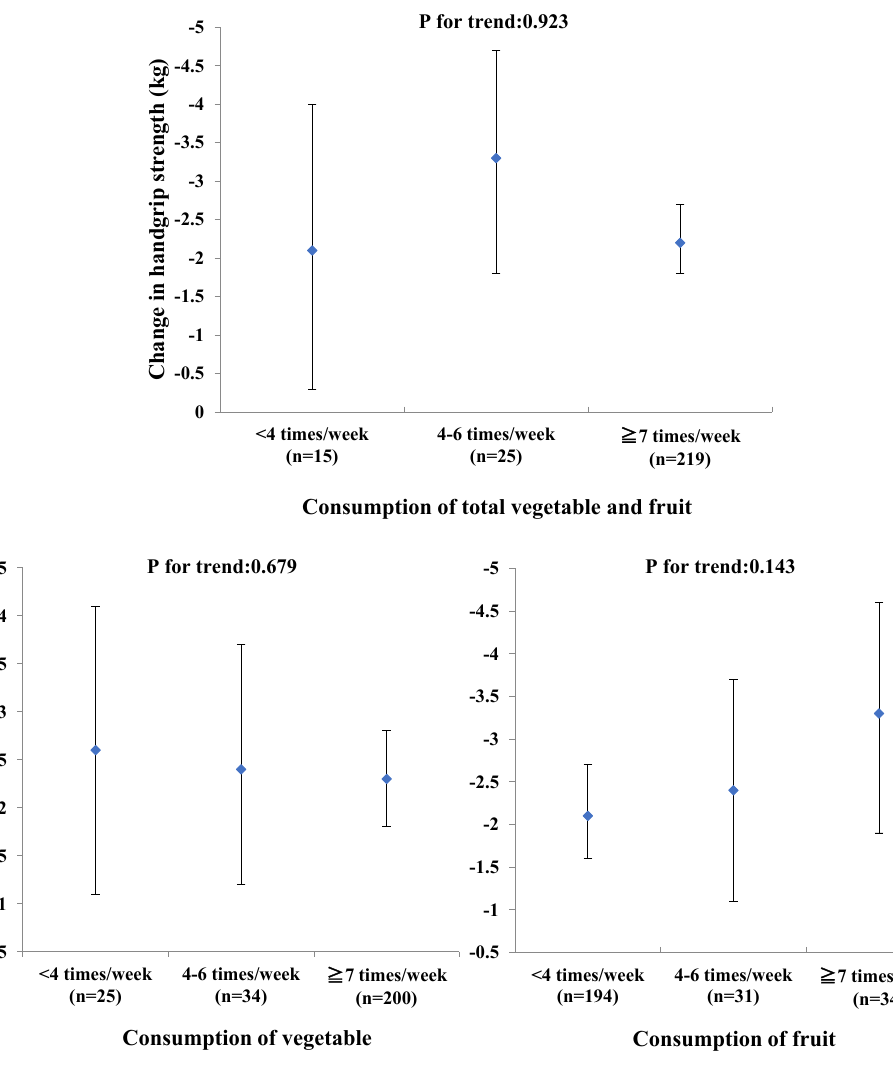
Figure 1. Pooled analysis of relationships of vegetable and fruit consumption with change in handgrip strength among Japanese adults (2008 – 2011). Means for change in handgrip strength are presented for total vegetable and fruit, vegetable, fruit consumption. The multivariate model that was adjusted for covariates as in Table 2 excluded total vegetable and fruit, vegetable, and fruit